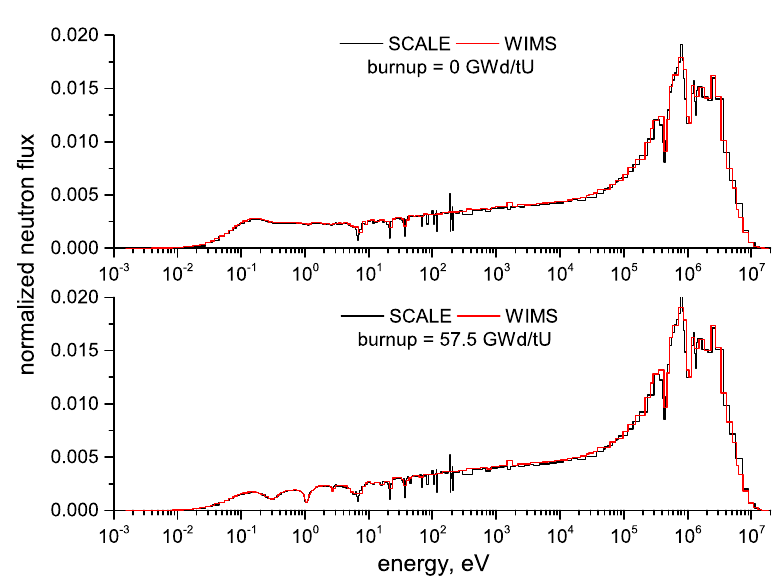
Figure 9. Flux distribution over neutron energy for the BWR pin-cell model in SCALE-6.2 (252 energy groups) and WIMS-10A (172 energy groups) for the BoL and EoL.